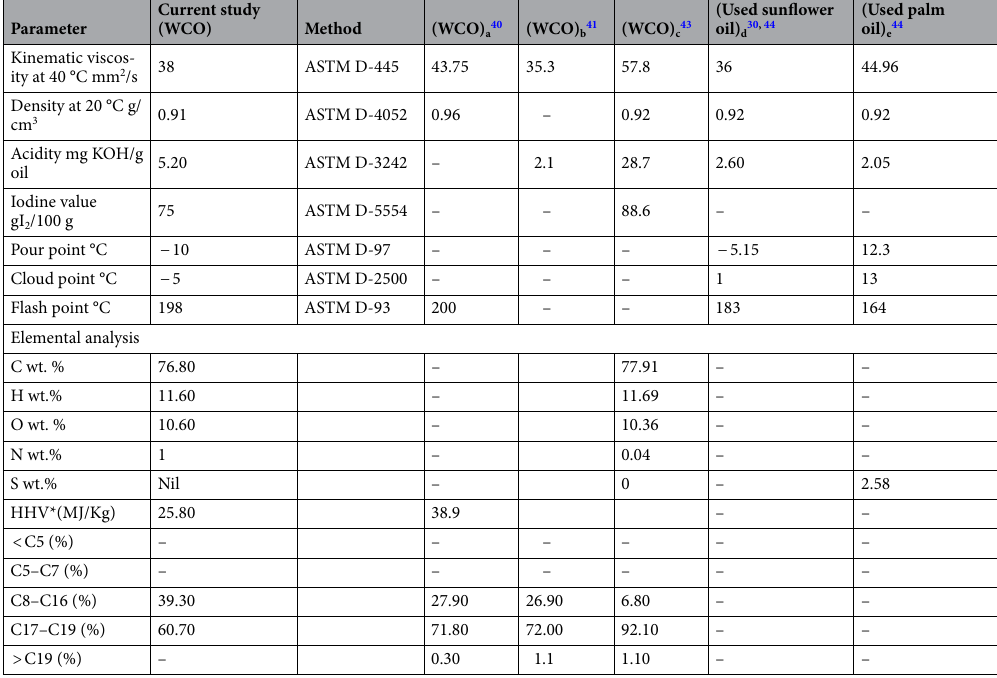
Table 1. The sample was cooled in a glass tube and studied at 1 °C intervals until a foggy structure became visible under specified conditions. This temperature was denoted by the symbol CP. To determine the PP, the sample was cooled in a glass tube under controlled conditions and evaluated at 3 °C intervals until no movement was detected even when the surface was kept vertical for 65 s; the PP was then calculated to be 3 °C above the tem- perature at which the flow stopped. The elemental analysis of the WCO sample was performed using the Agilent 5110 vertical dual view (VDV) ICP-OES. Characterization of catalyst. To characterize the prepared AL 2 O 4 (Co/Zn) catalyst Nano particles, various anal- yses were performed. BET surface area, Barrett − Joyner − Halenda (BJH) pore size and pore volume have been